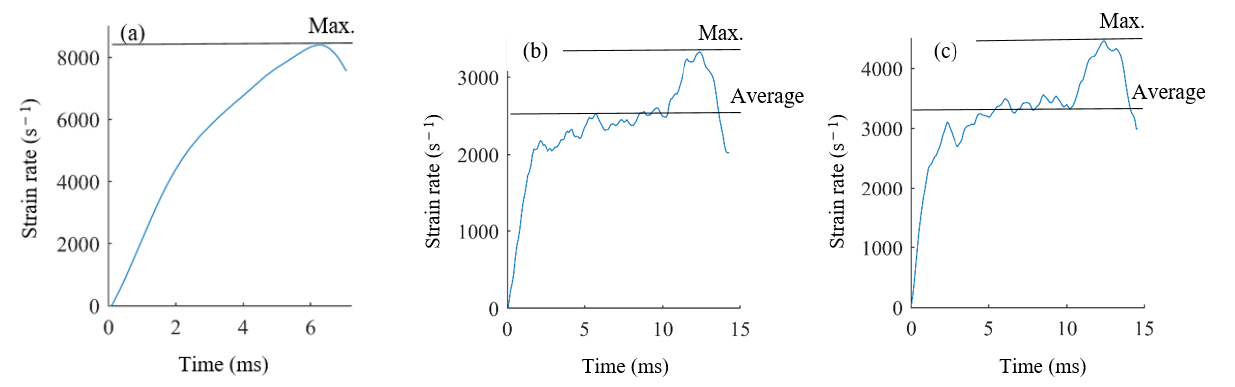
Figure 4. ( a ) Example of the strain rate vs. time in a compression test, ( b ) example of the strain rate vs. time during a shear test and ( c ) example of the strain rate vs. time during a tensile